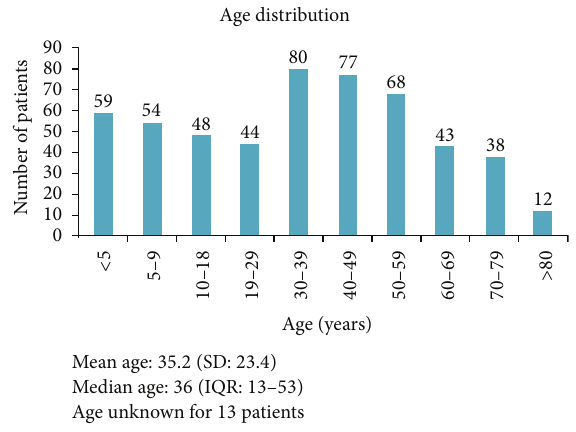
Figure 1: Age distribution of patients receiving surgery at the surgical camp, Uganda,